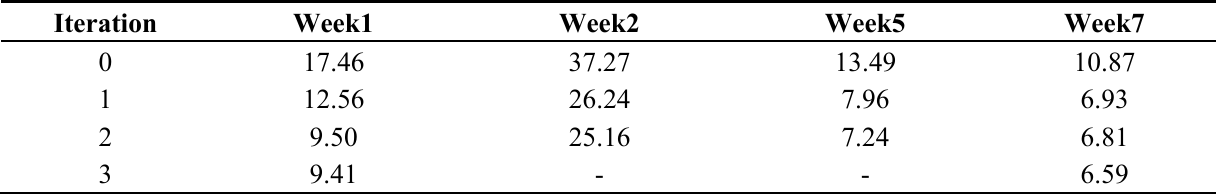
Table 5. Accuracy of the proposed iteration procedure in terms of AMAPE (%) for the four test weeks of year 2010.